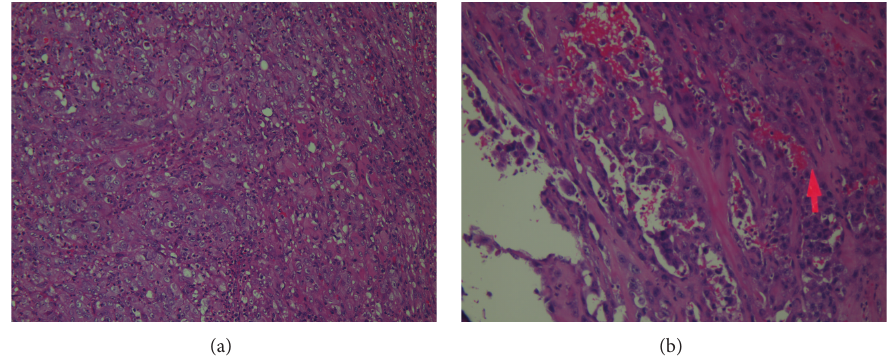
Figure 1: (a) Proliferation of cellular elements with epithelial appearance, with large vesicular nucleus, and with prominent nucleolus. (b) Areas consist of irregular spaces containing material blood bordered by atypical cells with intraluminal papillary